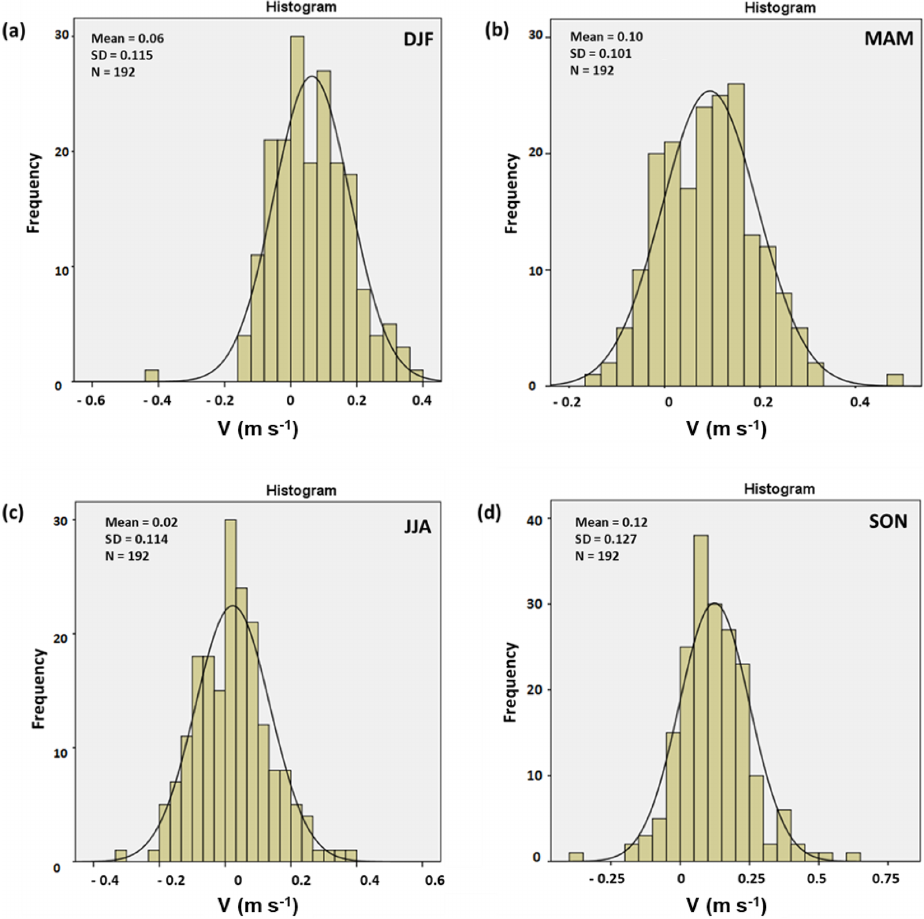
Figure 14. A probability distribution function of the EOF1 of zonal currents for the NW (a) , SE (c) , and transition (b, d) seasons at B SM at a depth of ∼ 40m.